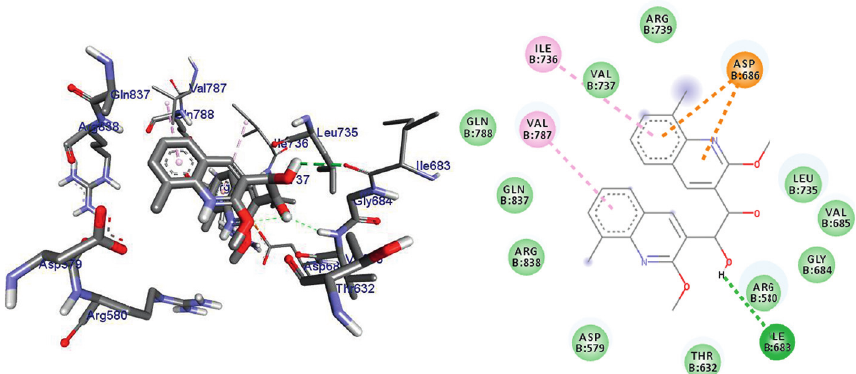
Figure 6: The binding interactions of compound 24 against E.coli DNA gyrase A (PDB ID: 1ZI0).